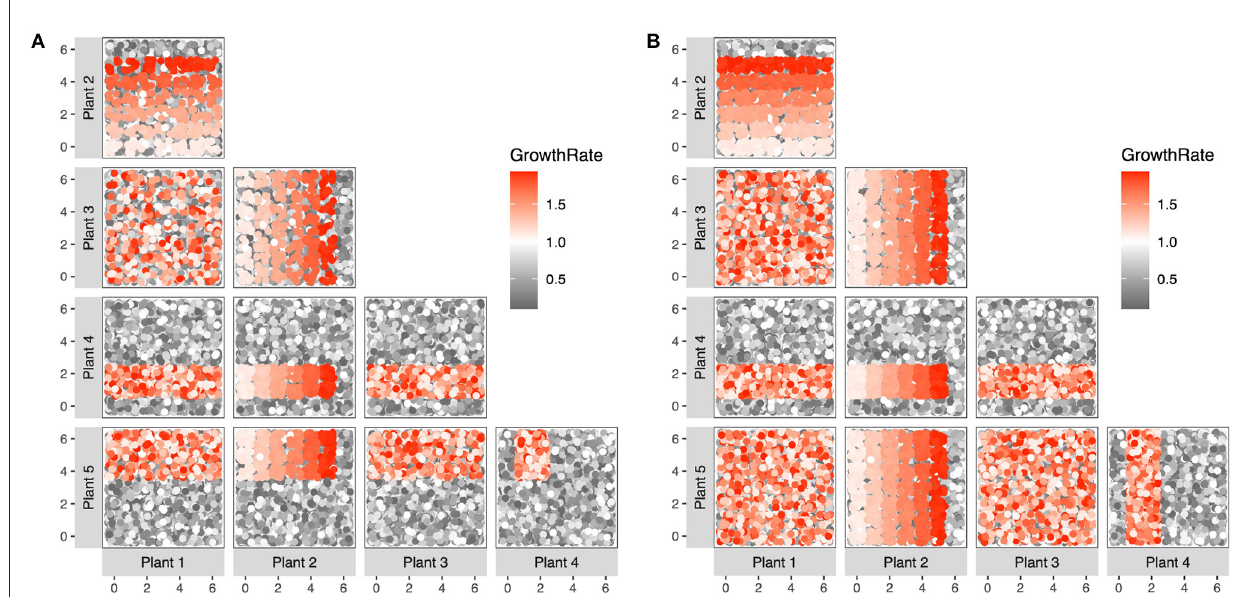
FIGURE4 Distribution of synthetic data used for model training. Each point in each scatter plot represents the combination of two plant values, colored according to the corresponding growth rate of that point. Gray values indicate growth rate values below 1 (leading to pack size decreases), and red values code values above 1 (leading to pack size increases). (A) Experiment 1: The growth rate scales linearly with plant 2, depending on values of plant 4 and plant 5. (B) Experiment 2: The growth rate scales linearly with plant 2, depending on values of plant 4. For clear rendering, only 0.2% of all training data are shown, with data points jittered around their true integer